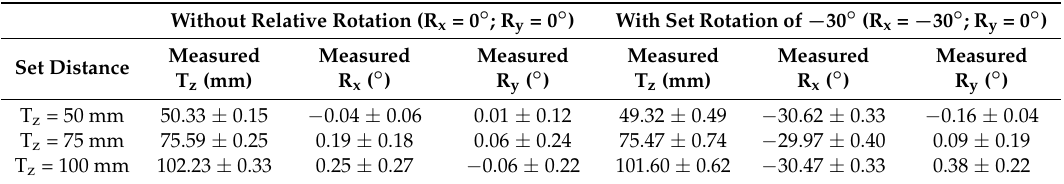
Table 3. 3-DOF transformation parameters measured when operating at three different distances to a planar surface, parallel to the compliant wrist (0 ◦ ), or with a − 30 ◦ rotation about X. Without Relative Rotation (R x = 0 ◦ ; R y = 0 ◦ ) With Set Rotation of − 30 ◦ (R x = − 30 ◦ ; R y = 0 ◦ )